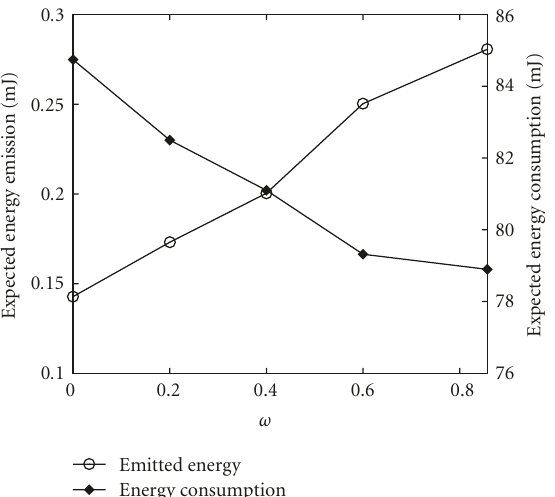
Figure 16: Trade o ff between minimum energy consumption and energy